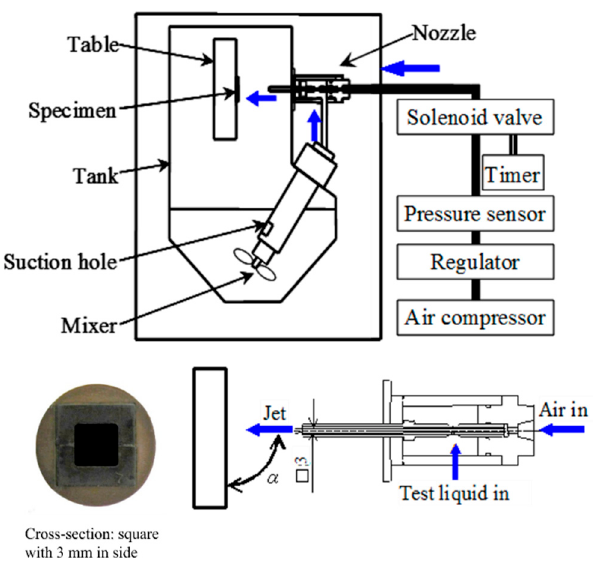
Figure 1. Schematic view of a MSE apparatus. The insert shows details of the nozzle. MSE uses a high-speed impingement of slurry-jet containing hard particles (erodents) such as alumina. In this study, alumina particles with an average diameter of approximately 40 mm were used as erodents and mixed with distilled water at 1 wt.%. An SEM image of the alumina particles is shown in Figure